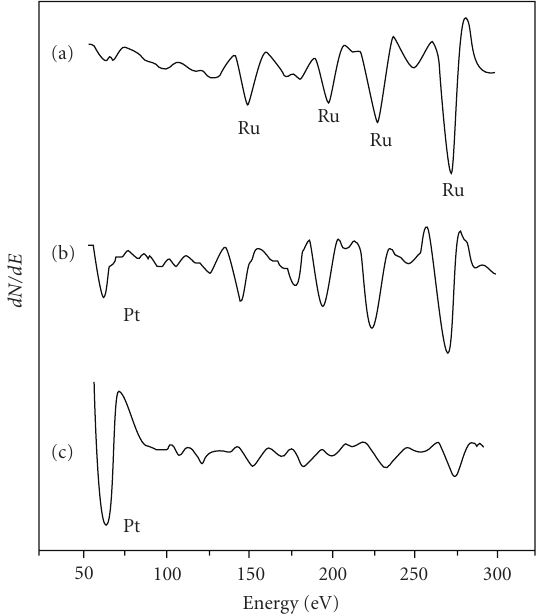
Figure 2: Auger electron spectra: (a) for a clean Ru(0001) surface after argon ion sputtering and annealing under UHV conditions, (b) for an Ru(0001) electrode covered with a submonolayer Pt by spontaneous deposition, and (c) the Ru electrode with Pt clusters formed by